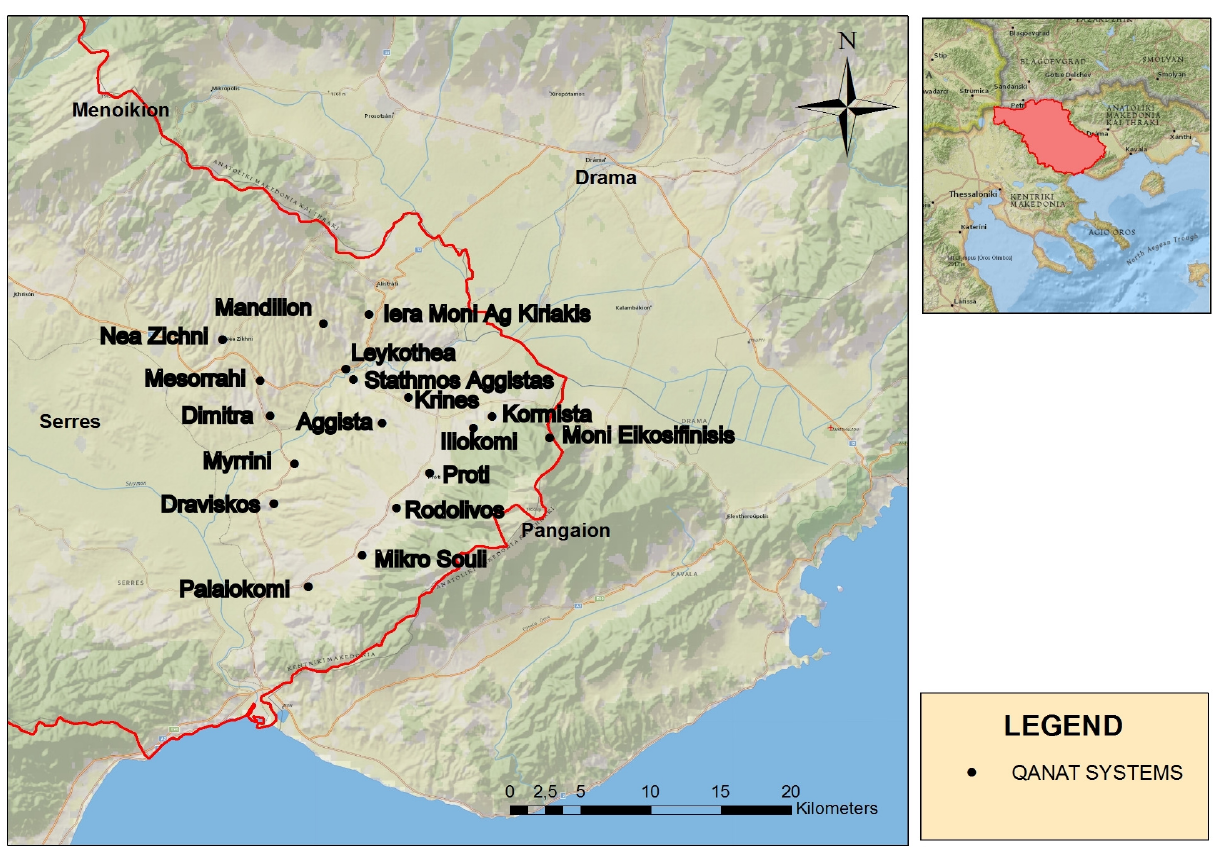
Figure 15. Sites of aqueducts-like qanats evidence in Phyllida region, North Hellas (with permission of G.